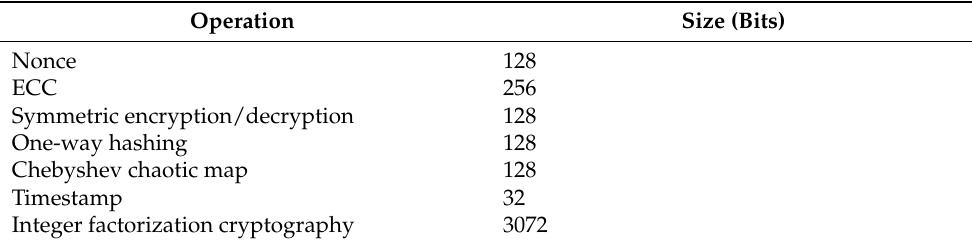
Table 4. Message